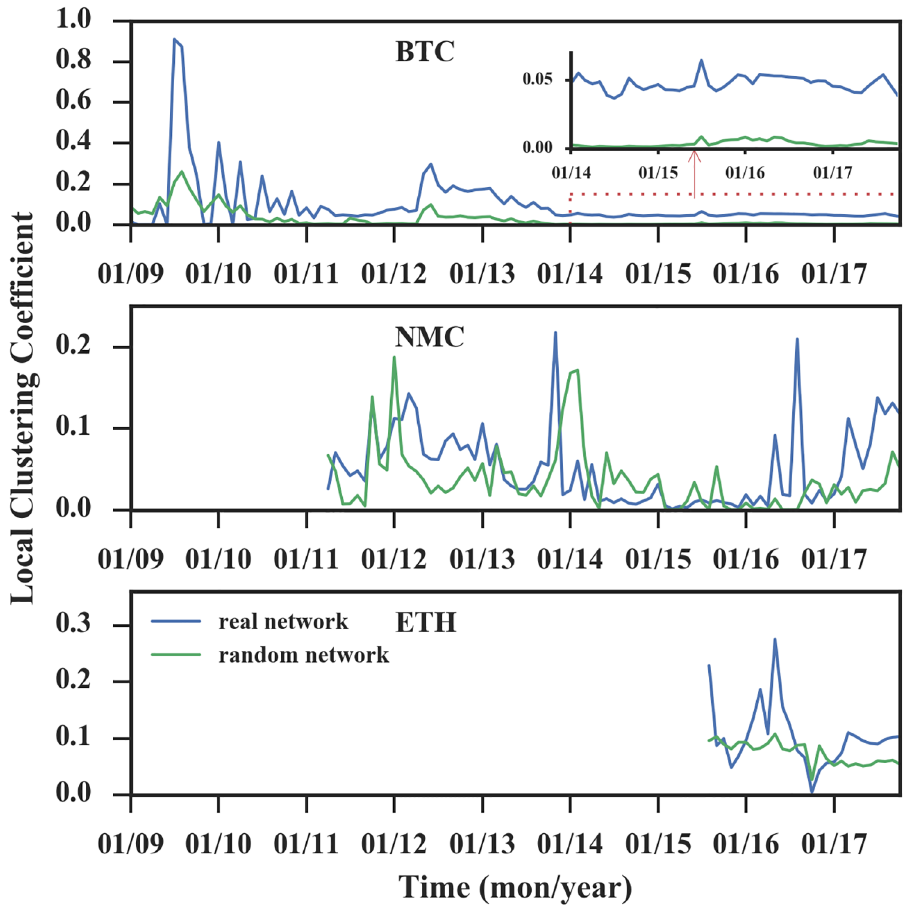
Fig 9. Evolution of clustering coefficients. If the average clustering coefficient of a network is rather higher than a random network with the same degree sequence, the network is a small-world network. In the figure of Bitcoin, we magnify the y-axis of the data in the red box and display it in the upper right corner. We find only Bitcoin exhibits this